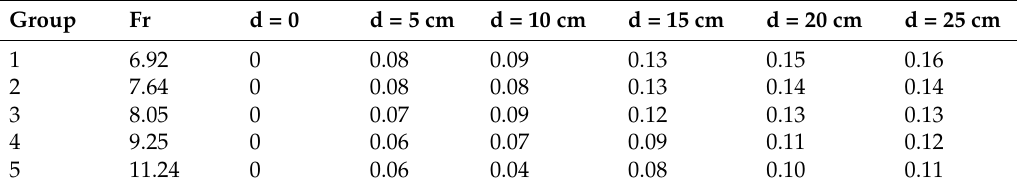
Table 2. Minimum of the dimensionless thickness of the water